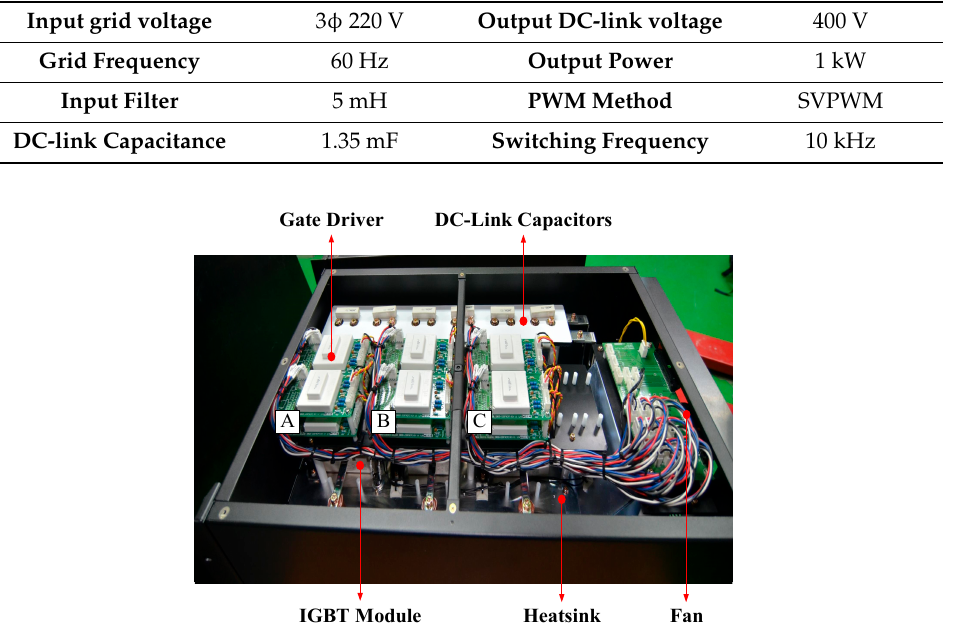
Table 4. Specifications and conditions of the experiment.